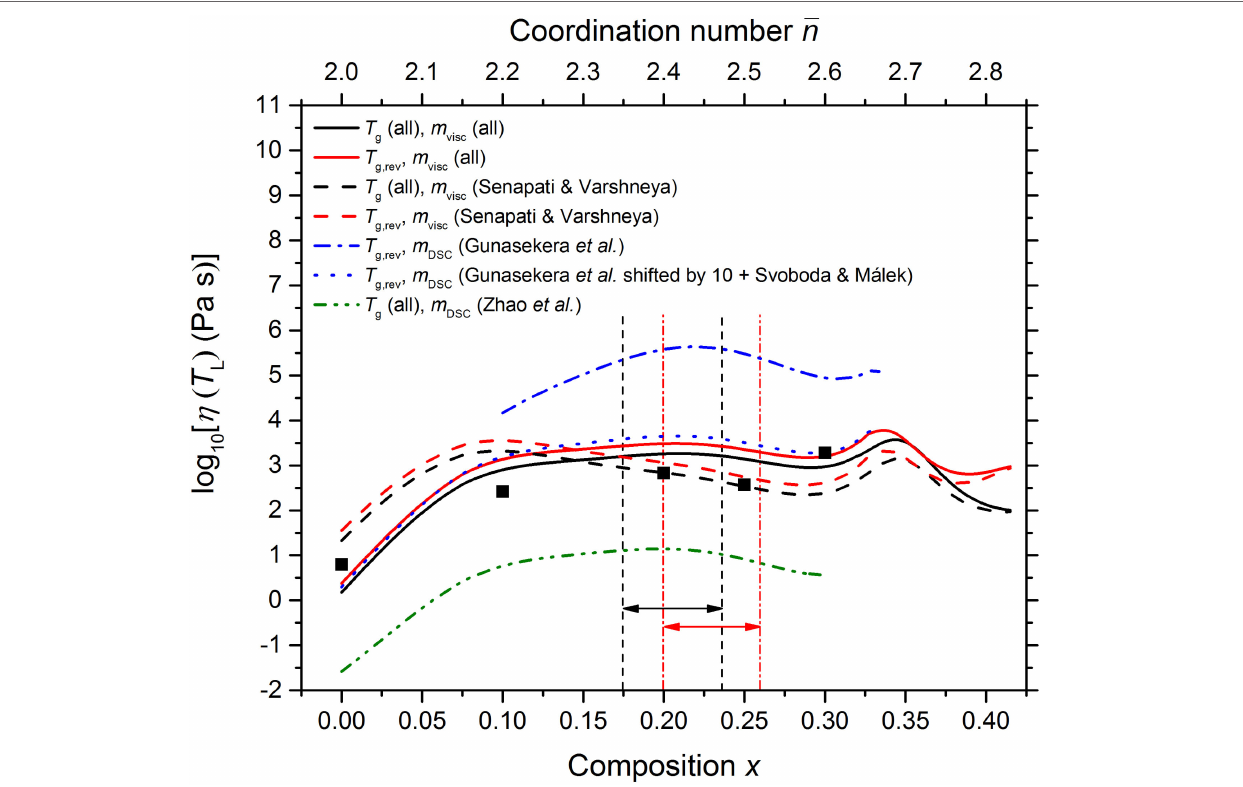
FIGURE 14 | The dependence of log 10 (cid:17) ( T L ) for the Ge x Se 1 (cid:0) x system, as calculated using the MYEGA model with log 10 [ (cid:17) 1 (Pas)] = − 2.93, on the composition x and mean coordination number ¯ n = 2 ( 1 + x ) . The solid (black) squares correspond to the fitted data sets shown in Figure 11 where the associated m visc values are listed in Table 1 . The solid (black) and solid (red) curves show the results obtained by taking m visc from the solid (black) curve in Figure 12 and T g / T L from either the solid (black) or broken (red) curve in Figure 13 , respectively. The broken (black) and broken (red) curves show the results obtained by taking m visc from the broken (red) curve in Figure 12 and T g / T L from either the solid (black) or broken (red) curve in Figure 13 , respectively. The chained (blue) and dotted (blue) curves show the results obtained by taking T g / T L from the broken (red) curve in Figure 13 and by assuming that m visc ≃ m DSC , with m DSC either (i) taken from the results of Gunasekera et al. (2013) or (ii) obtained by combining the results of Svoboda and Málek (2015) with the shifted results of Gunasekera et al. (2013) (see Figure 12 ), respectively. The chained (green) curve shows the results obtained by taking T g / T L from the solid (black) curve in Figure 13 and by assuming that m visc ≃ m DSC , with m DSC taken from the results of Zhao et al. (2013). The pairs of vertical dashed (black) or chained (red) lines, and associated horizonal arrows, mark compositions for which ∆ H nr ≃ 0 as found in the present work or in the work of Boolchand et al. (2001a), respectively.